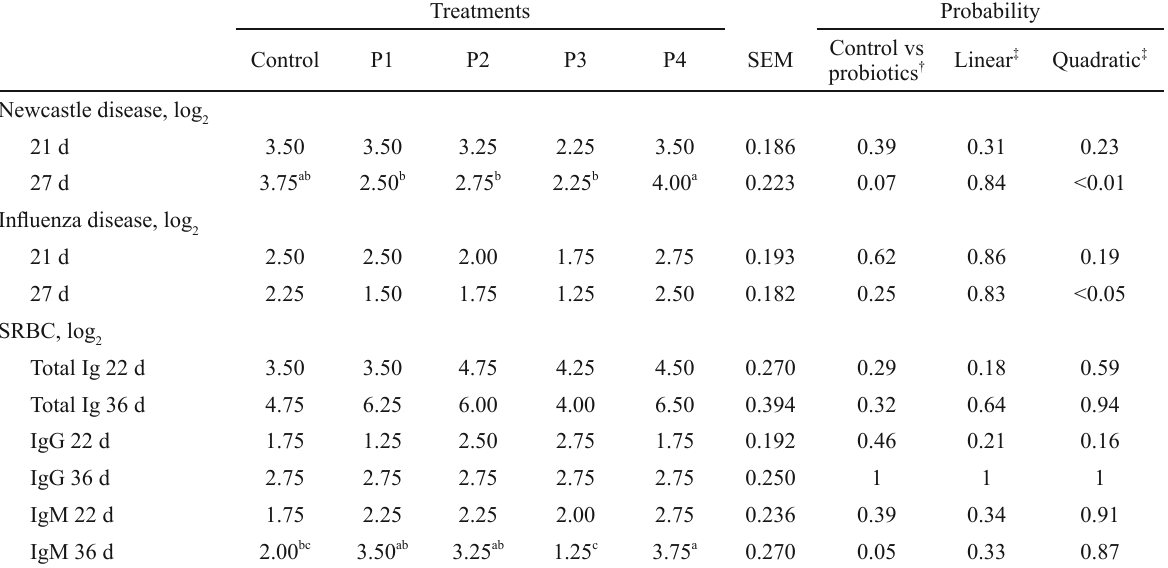
Immune response after vaccination or injection of sheep red blood cells (SRBC) in broilers fed diets containing either no probiotics (control) or 0.005%, 0.01%, 0.015% and 0.02% of probiotics (P1, P2, P3 and P4, respectively). All data were obtained from four birds per treatment. Treatments